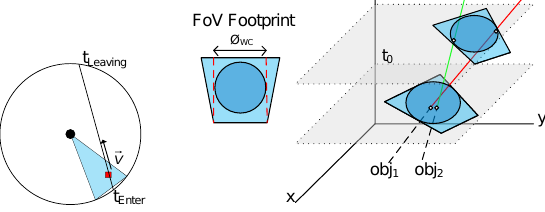
Figure 11: This figure shows exemplarily trajectories and three cameras. If an object leaves the observation range of camera 1 it will be re-detected with a higher probability in the viewing range of camera 2 than in the FoV of camera 3